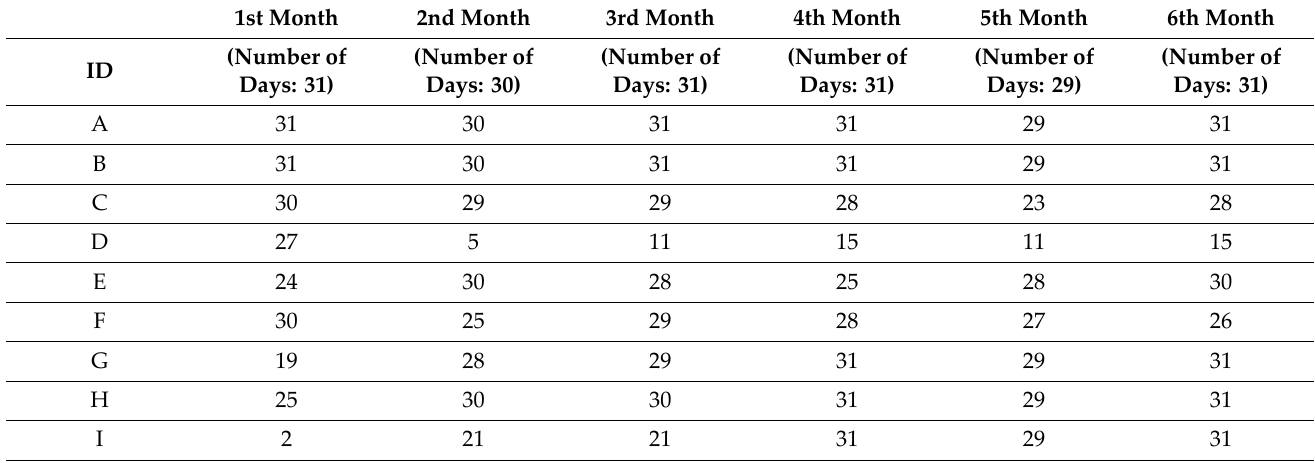
Table 2. Number of days the participants used the communication application (app).